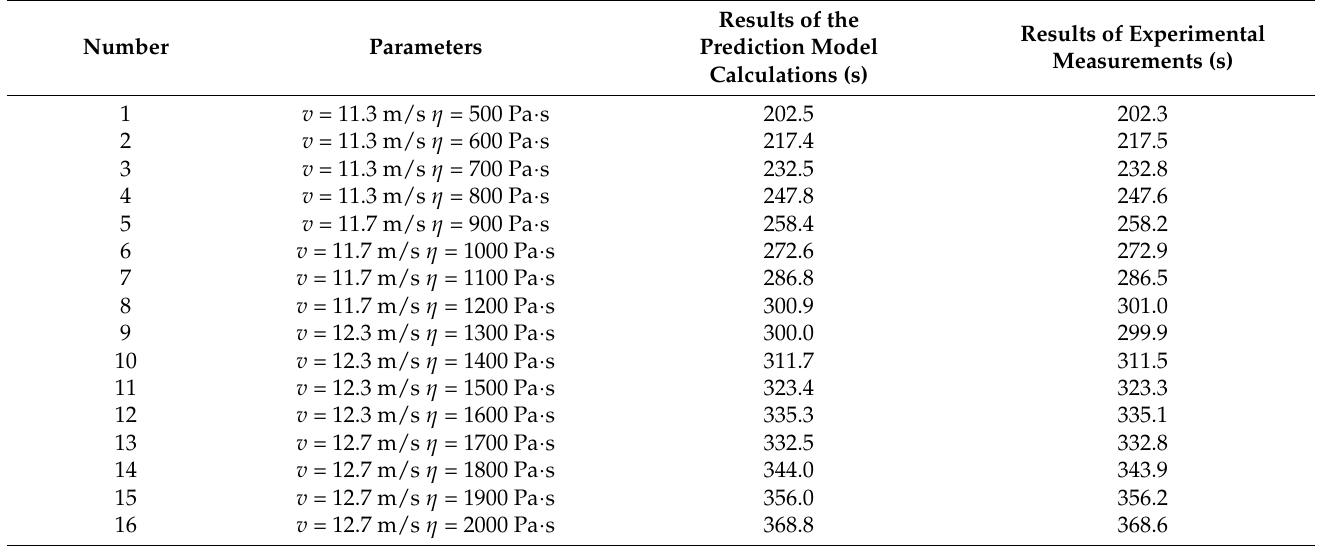
Table 10. Comparison between the calculated results of the prediction model and the experimental results for the transfer period of the surface